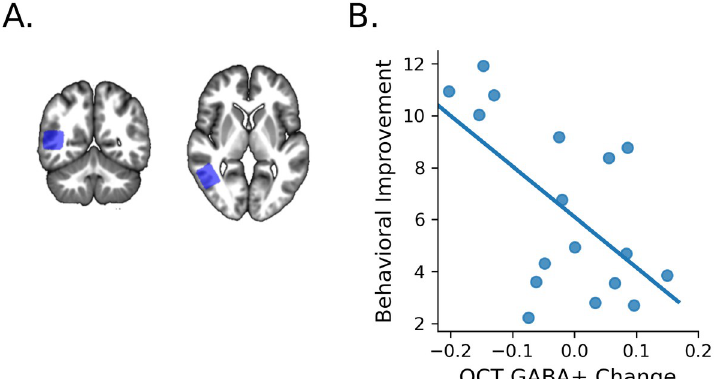
Fig 4. Visual GABAergic plasticity. (A) Group MRS voxel mask (cortical region common in 50% or more of participants) indicates OCT voxel placement displayed on the average MT scan across participants (MNI x: 47.2 y: − 53.60 z: 8.80 (mm)), in MNI space (radiological convention, R-L). No significant differences in data quality measures were observed across sessions (S3 Table). ( B) Significant negative correlation between OCT GABA+ change and behavioral improvement ( n = 17; r = − 0.60, p = 0.012, CI [ − 0.85, − 0.07]). Source data are provided at: https://doi.org/ 10.17863/CAM.93457. MT, magnetization transfer; OCT, occipito-temporal